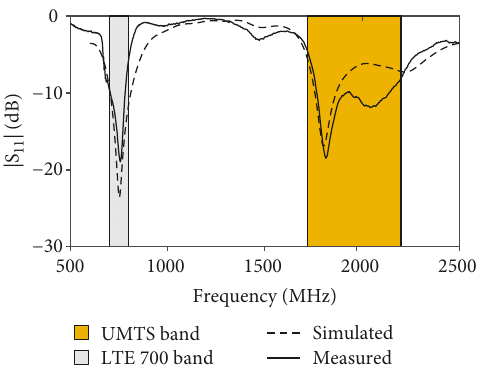
Figure 5: Measured and simulated | S